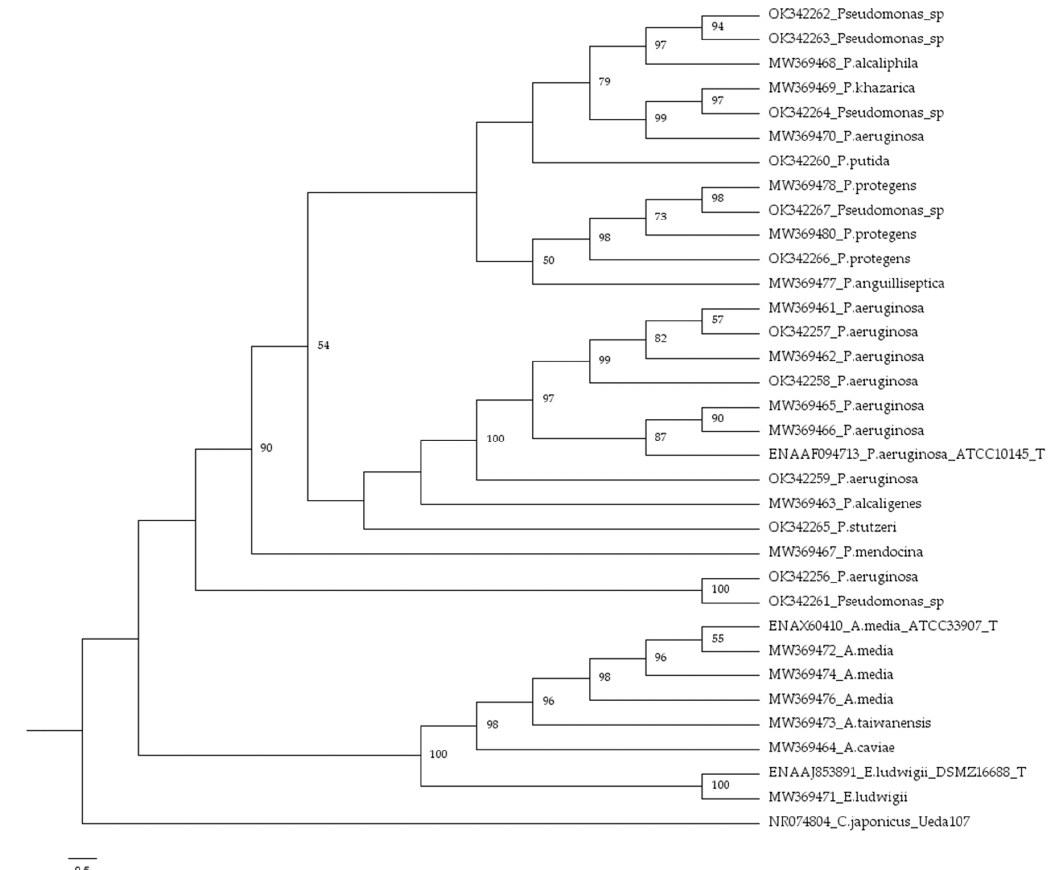
Figure 2. Phylogenetic tree based on 16S rRNA gene sequences comparison between the intestinal strains and reference collection strains. NR074804 Cellvibrio japonicus strain Ueda 107 was used as the outgroup strain. Each node indicates the percentage of the obtained bootstrap values higher than 50% of 1000 replicates. The scale bar indicates sequence divergence.